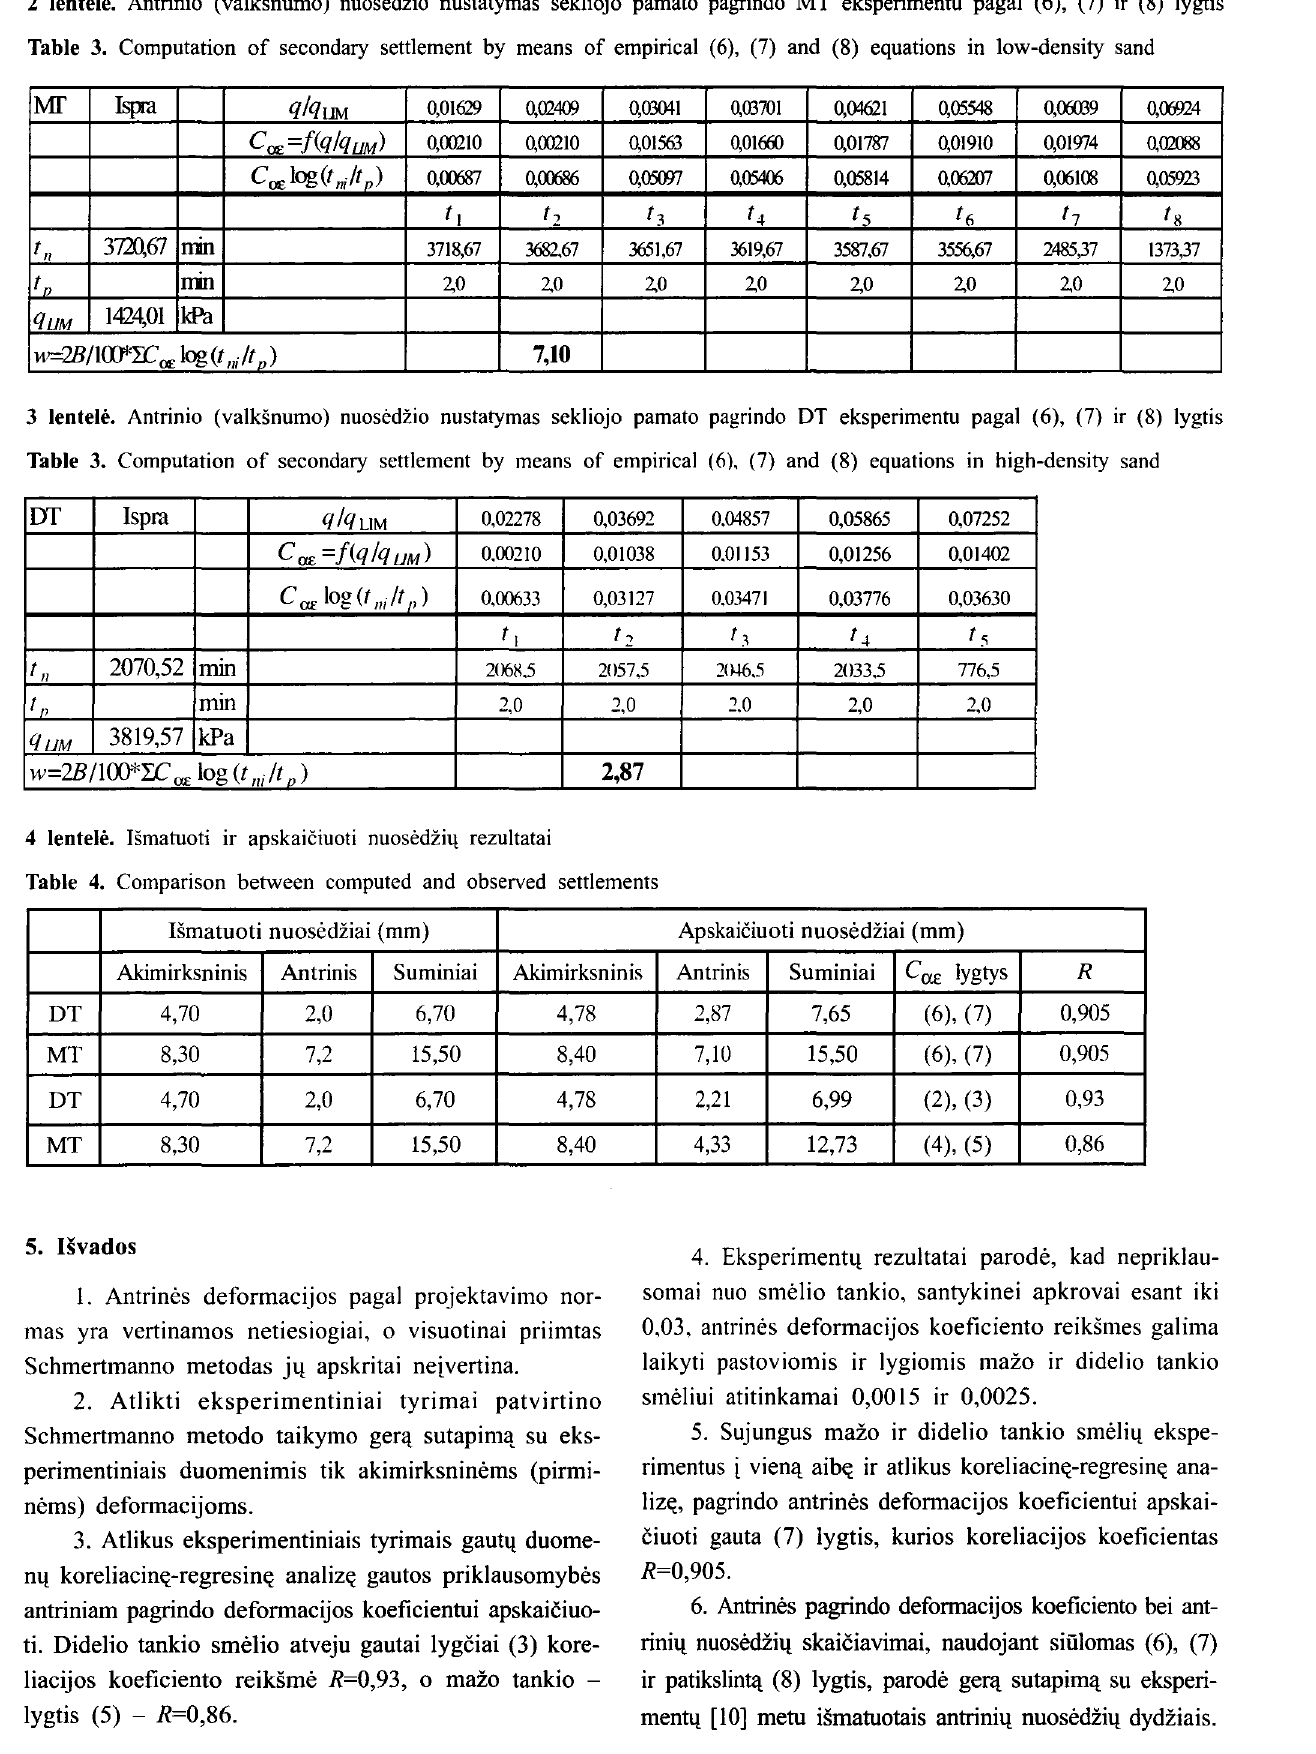
Table 3. Computation of secondary settlement by means of empirical (6), (7) and (8) equations in low-density sand Mr